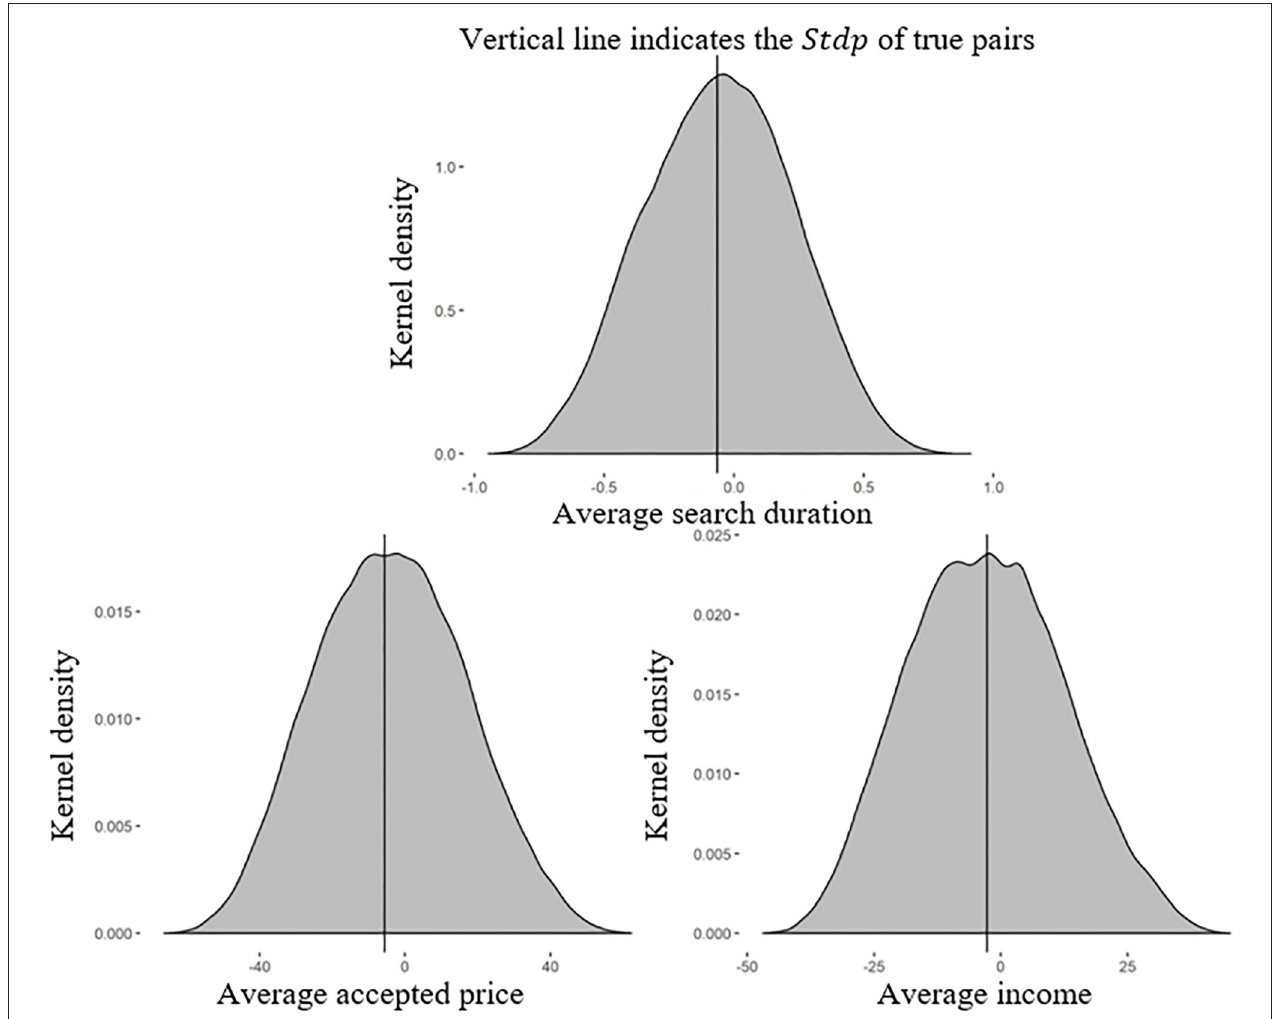
FIGURE 3 | Kernel density of the Stdp of the true pairs in the pair-with-feedback treatment and the simulated pairs in the single treatment. The differences between the Stdp s of the pair-with-feedback and single treatments were approximately symmetric around zero, which was exactly what we would expect in the absence of peer